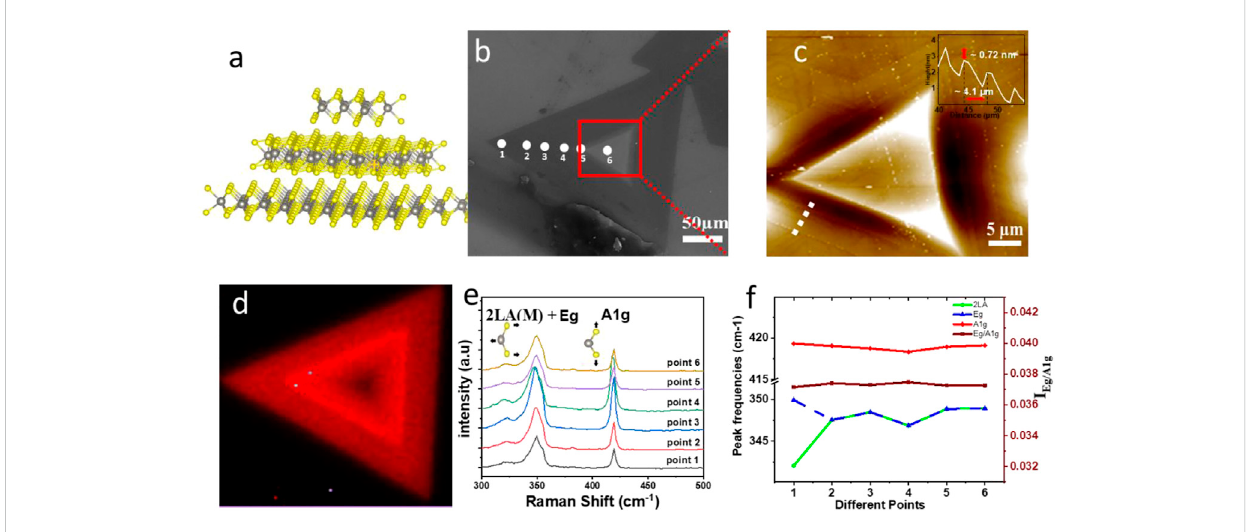
FIGURE 2 Layer by Layer (LBL) growth. (A) Illustrations of the crystal LBL structure. (B) SEM image of WS 2 LBL structure. (C) AFM image corresponding to the marked red square in SEM image. (D) Raman intensity mapping of E 1 2 g mode (348 cm -1 ). (E,F) Raman spectra and peak positions ( A 1 g , E 1 2 g , 2 LA ) as well as intensity ratios of I E 1 / I A of six points from edge to center, as marked in SEM 1 g 2 g